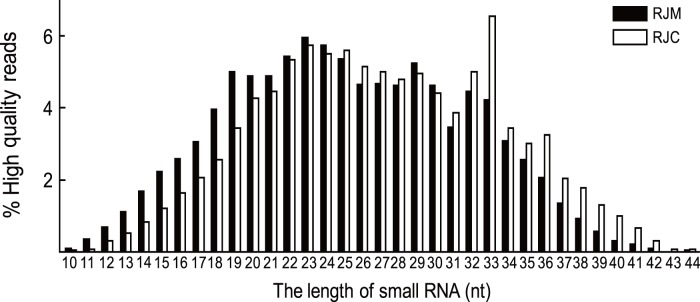
Length distribution of tags produced by small RNA sequencing in Royal jelly of Apis mellifera (RJM) and Royal jelly of Apis cerana (RJC).The horizontal axis indicated length nucleic acid (nucleotides, Nt), the ordinate represented distribution frequency (%).